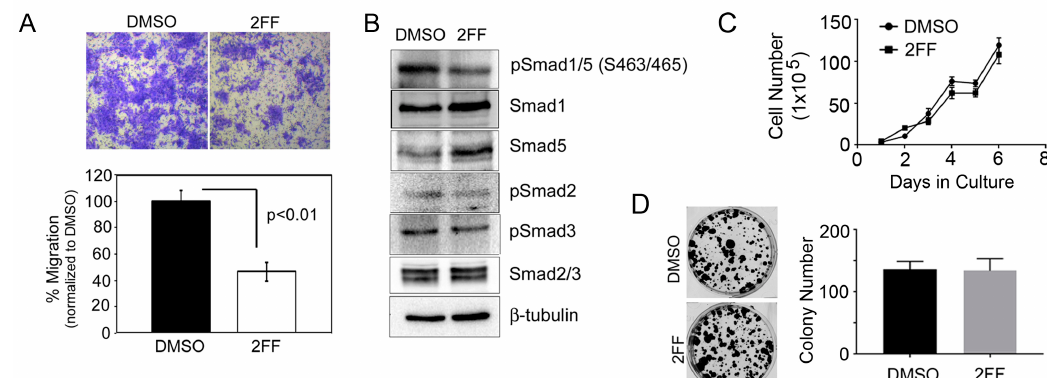
Figure 2. The role of fucosylation in regulating migration of 4T1 cells. ( A ) Crystal violet staining and quantitation of 4T1 cell migration. Cells were treated for 48-h with DMSO (control) or 100 µ M 2FF prior to plating for the migration assay. Migration assays were imaged at 200 × magnification. ( B ) 4T1 cells treated with DMSO or 100 µ M 2FF were probed by Western blotting with antibodies against Smad2 / 3, and Smad1 / 5 / 8 signaling pathways. β -tubulin was used as loading control. ( C ) 1 × 10 5 4T1 cells were plated per well and counted each day for 7 days. Cells were treated with DMSO (control) or 100 µ M 2FF on days 1, 3, and 5 of the assays. ( D ) 2 × 10 3 4T1 cells were plated per well and treated with DMSO or 100 µ M 2FF. Media containing DMSO or 2FF was refreshed every three days. Cells were stained with crystal violet and counted on day 14. Colony formation was not a ff ected by fucosylation in 4T1 cells.